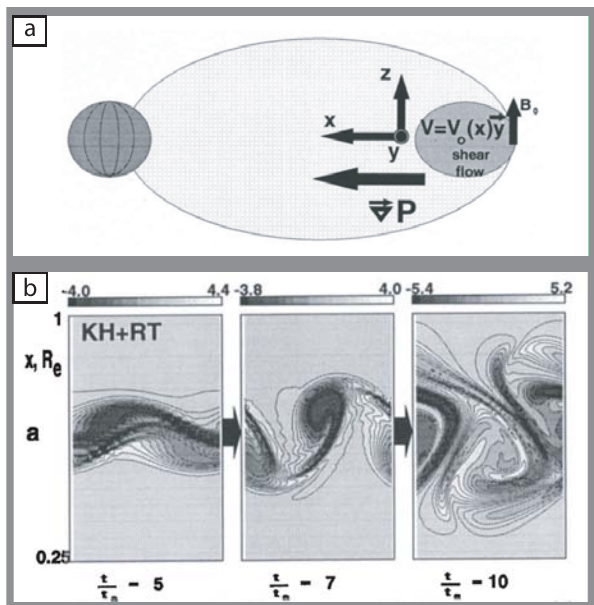
Fig. 13. (a) Illustration from Voronkov et al. (1997), show- ing a shear flow and pressure gradient in the near-Earth plasma sheet. (b) Results from a computer simulation of a hybrid (Kelvin- Helmholtz and Rayleigh-Taylor) instability for three selected times (from Voronkov et al., 1997), showing different stages of vortex